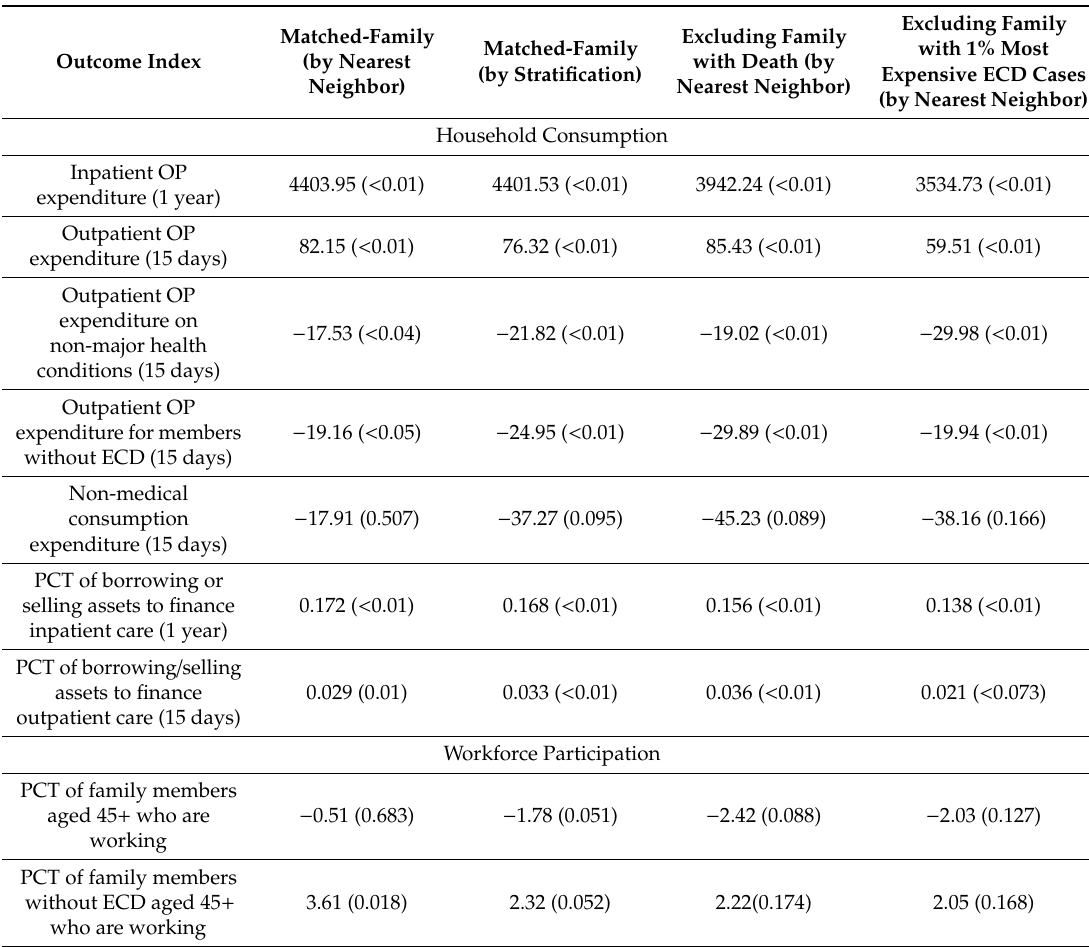
Table 5. Robustness check-e ff ect of ECD on family consumption and workforce participation in China. (Unit: CNY per family